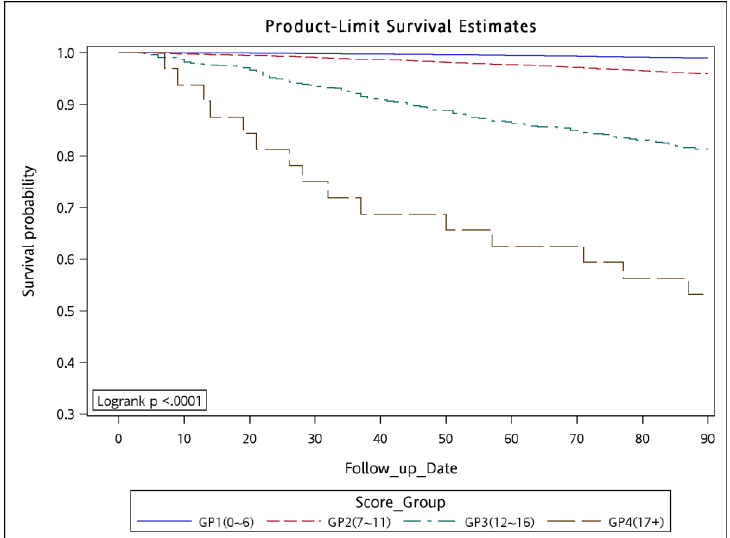
Figure 1. Kaplan–Meier curves for 90-day survival in patients with locoregionally advanced head and neck squamous cell carcinoma receiving curative surgery associated with the four risk groups. Note: p -value of Log Rank Test is <0.0001.